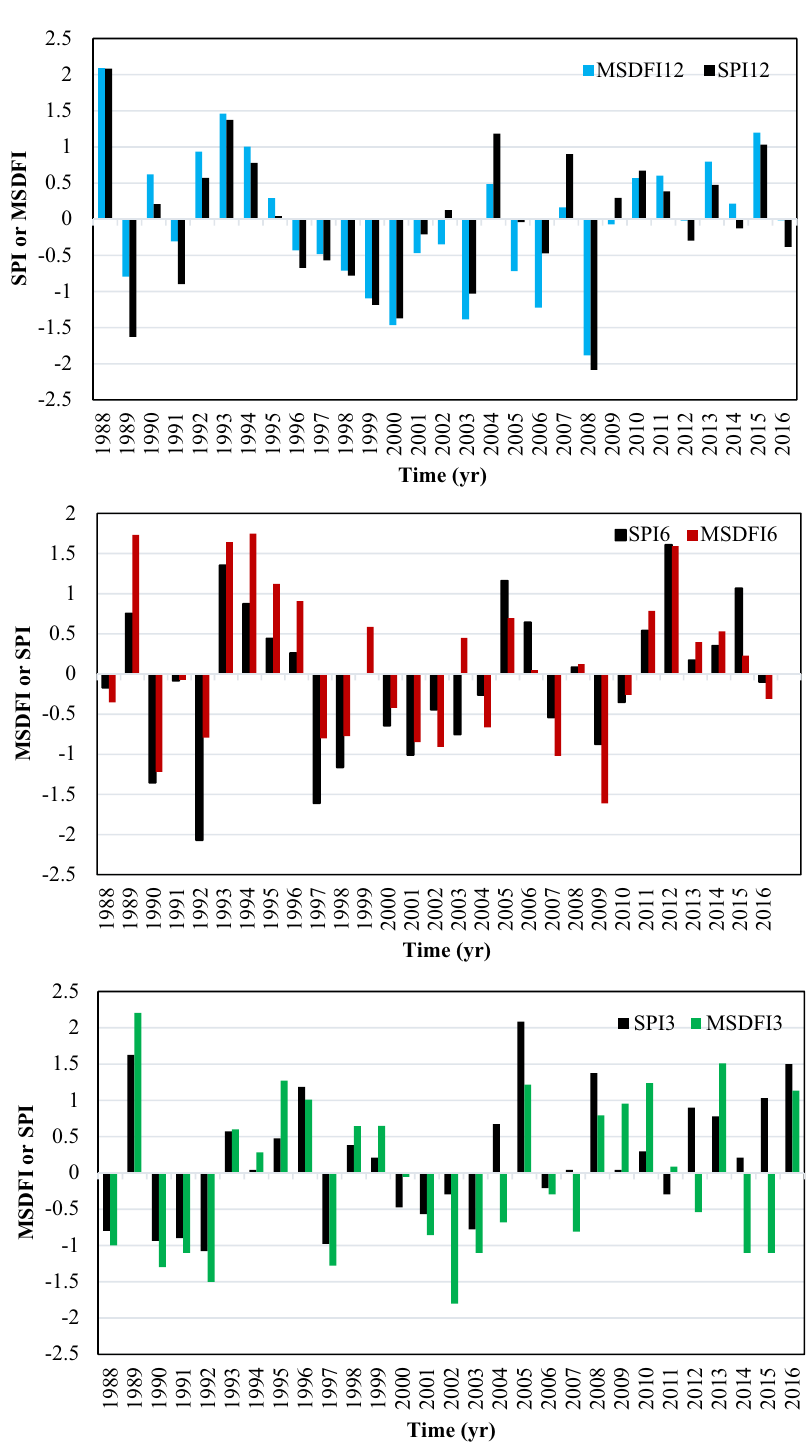
Figure 10. SPI and MSDFI histogram for aggregated ( a ) 12 months ended in September, ( b ) 6 months ended in March, and ( c ) 3 months ended in June for